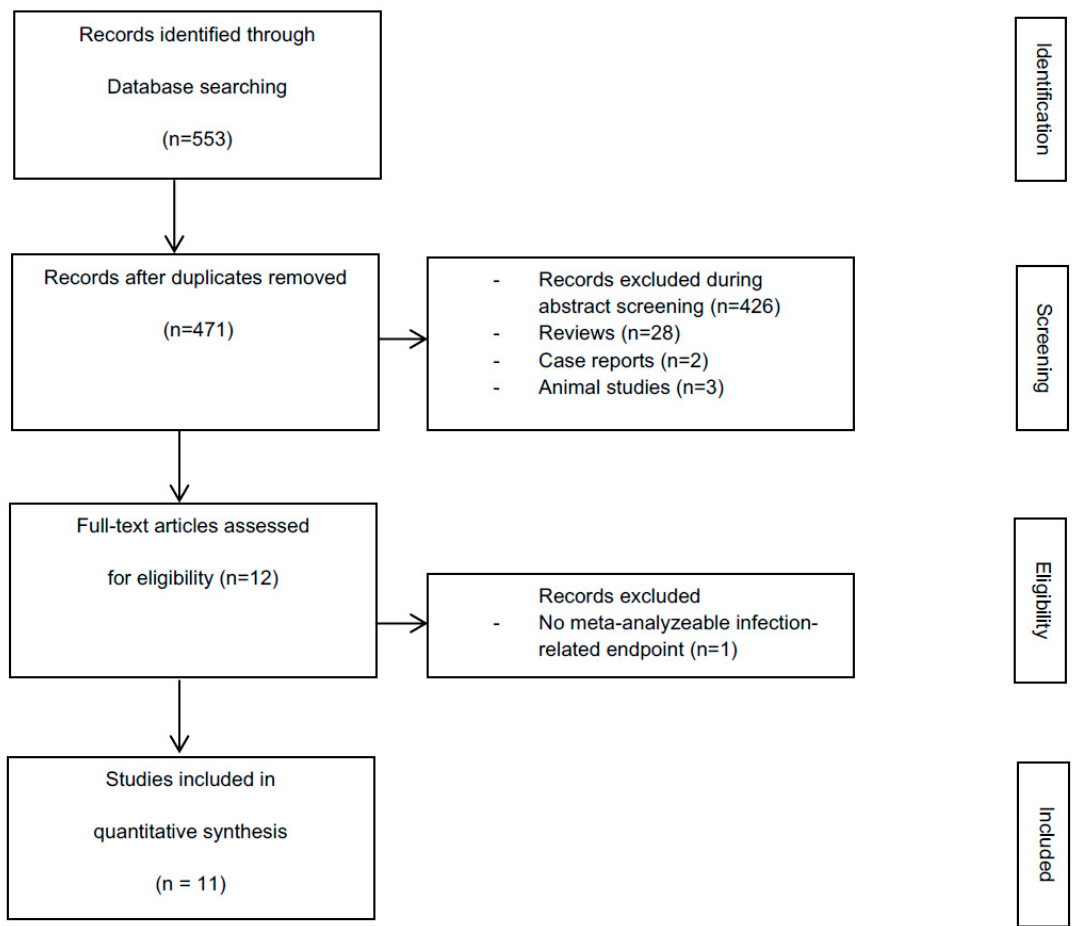
Figure 1. Flow chart depicting the screening and selection process for the systematic review of pro- /synbiotics on the prevention of infections and perioperative liver function.